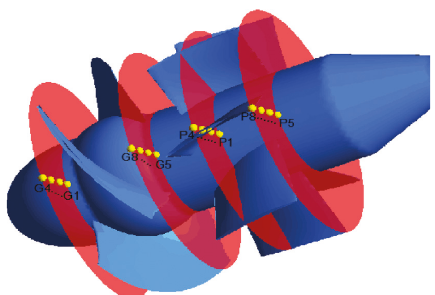
Figure 4: Four sets of pressure fluctuation monitoring